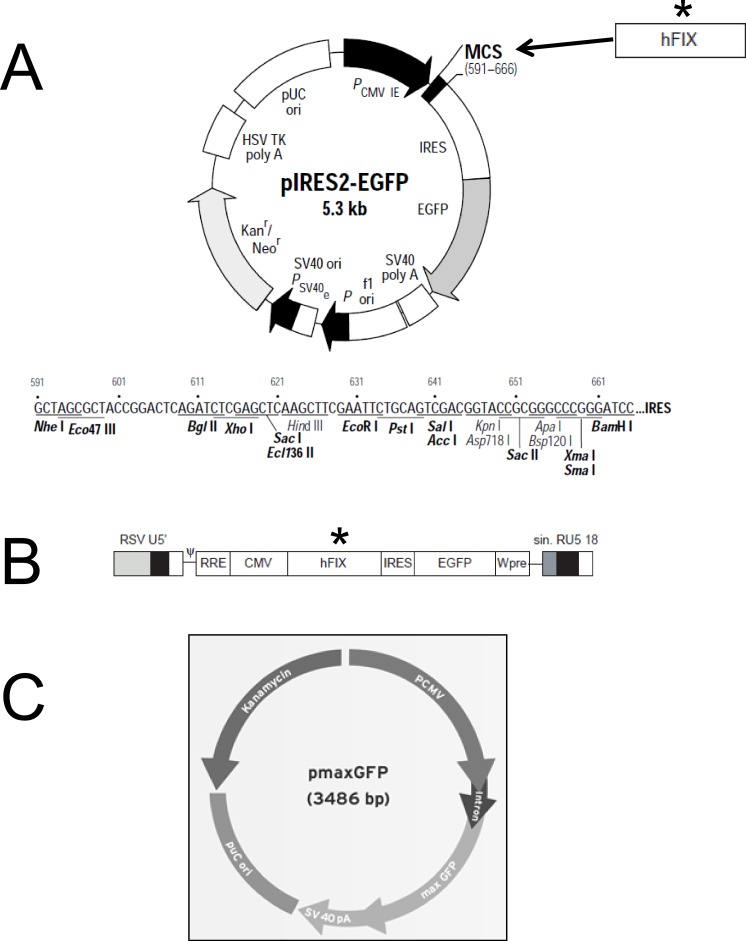
Plasmid constructions used for gene transfer studies.(A) Restriction map and multiple cloning site (MCS) of pIRES2-EGFP vector (Clontech). (∗) The DNA fragment containing intron-1 and human FIX cDNA was isolated from prrl.hFIX.IRES.EGFP and cloned into BamHI site of pIRES2-EGFP vector to obtain the pIRES2-EGFP-FIX plasmid. (B) Schematic representation of prrl.hFIX.IRES.EGFP lentiviral vector. (C) pmaxGFP vector (Lonza)™.